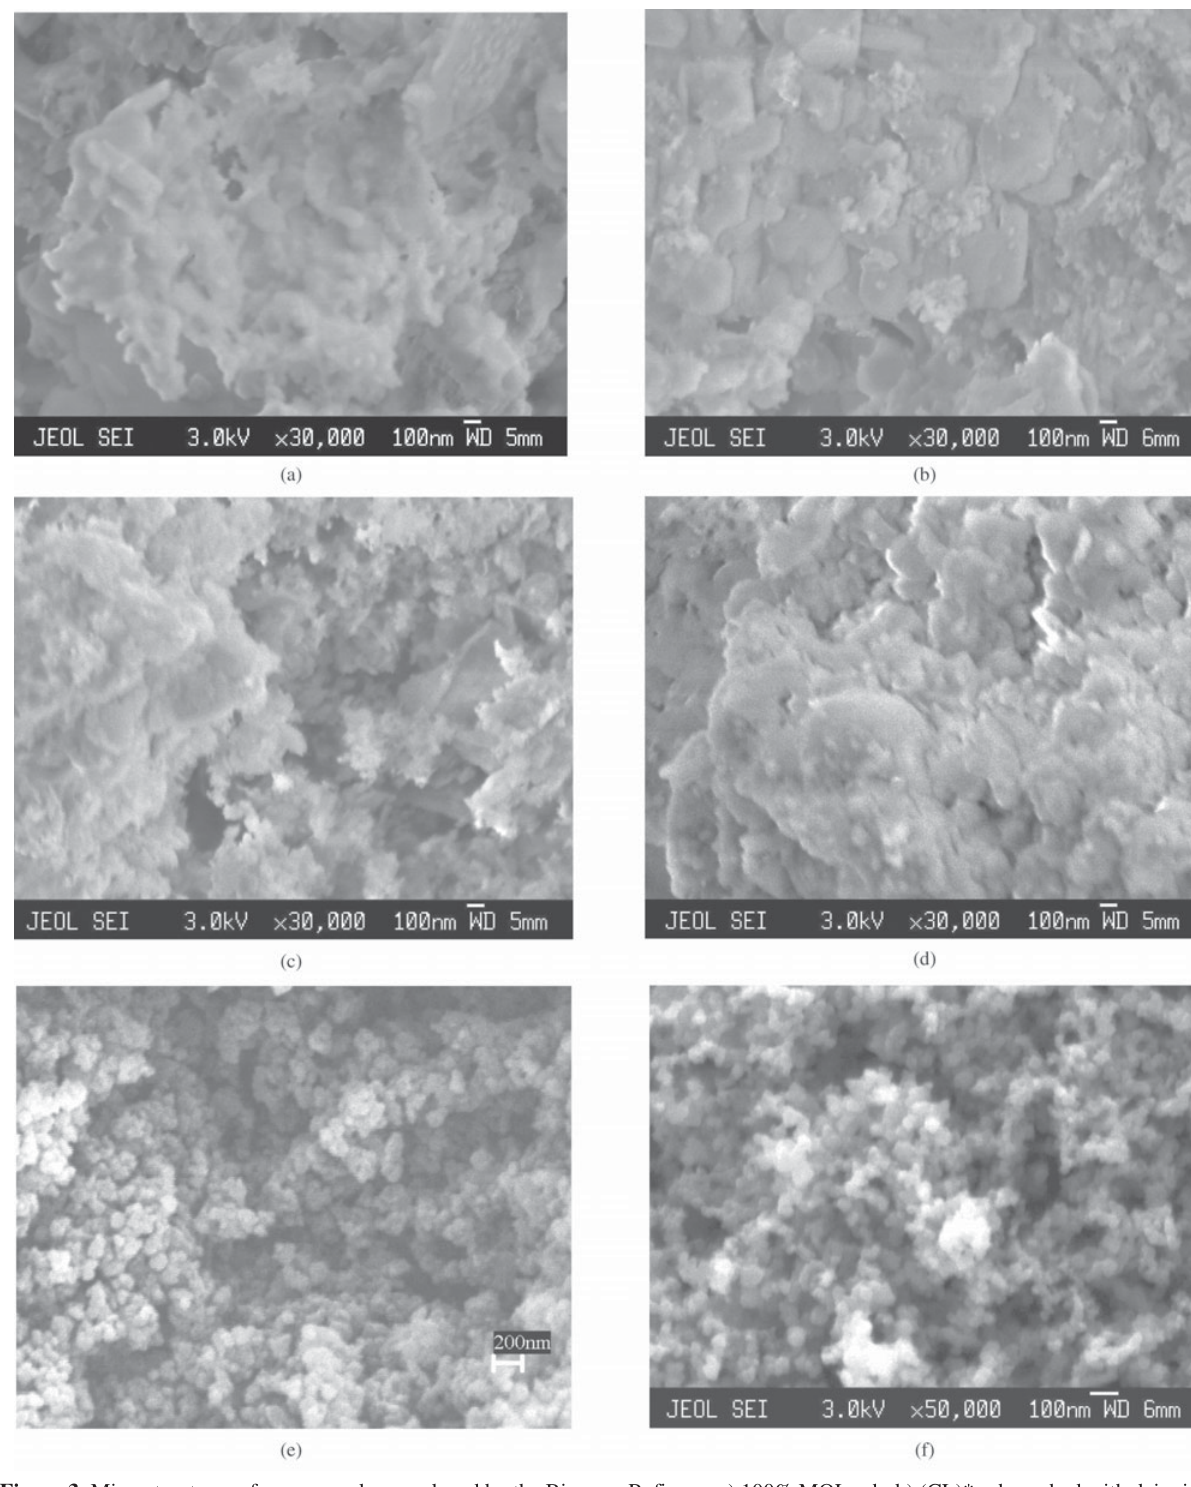
Figure 3. Microstructures of some powders produced by the Biomass Refinery: a) 100% MOL ash; b) (CL)* ash washed with deionised water; c) 100% wood with bark CL ash washed with deionised water; d) Silica of rice husk CL washed with potable water and burned at 700 °C; e) Recovered carbon black from tires by LTC, 420 °C, heated at 800 °C for 30 min and desagglomerated by attrition mill; f) Commercial carbon black